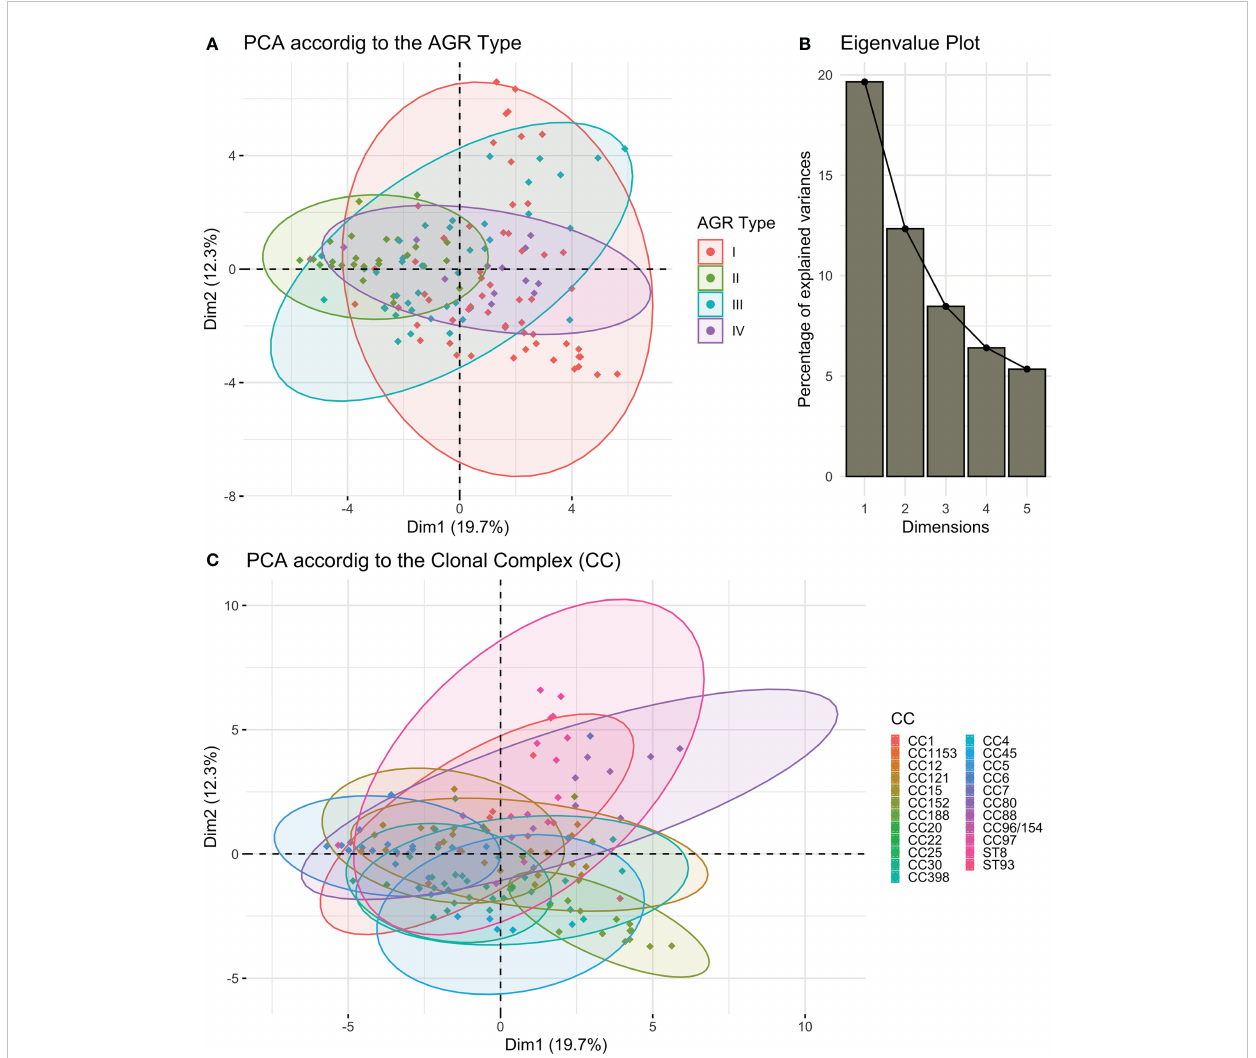
FIGURE 3 S. aureus proteome according to the strains ’ genetic backgrounds. Principal component analysis (PCA) on the log2-transformed relative protein quantities was conducted. (A) The variations in the virulomes depending on the 1 st and 2 nd dimensions of the PCA analysis are visualized according to the AGR type. (B) The associated Eigenvalue plot for the fi rst fi ve dimensions of the PCA is represented using a histogram plot. (C) The variations in the virulomes depending on the 1 st and 2 nd dimensions of the PCA analysis are visualized according to the clonal complex